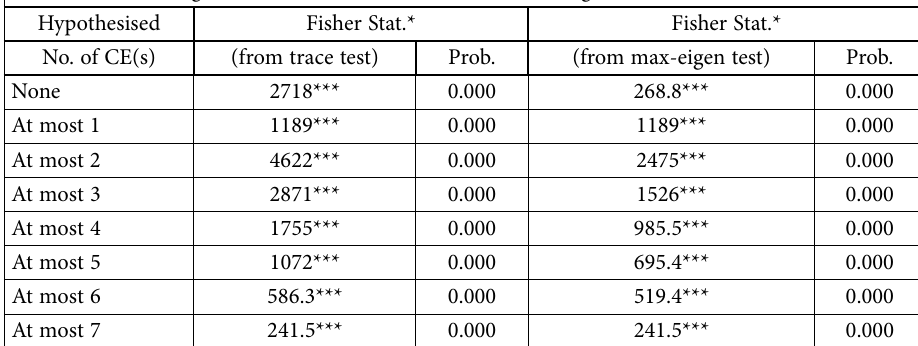
Table 5. Johansen Fischer Cointegration